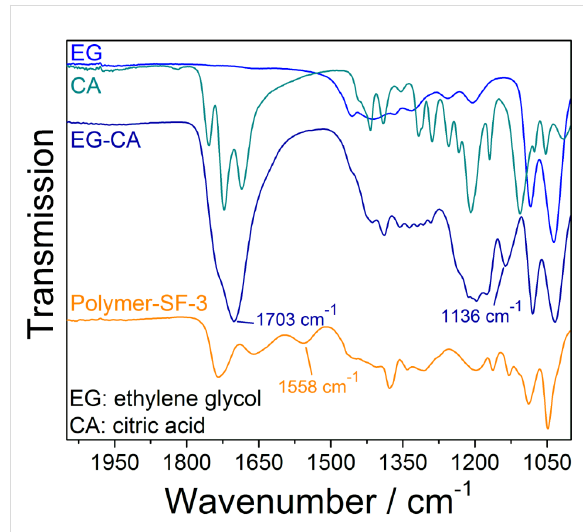
Figure 2: Infrared spectra of the monomers ethylene glycol (EG, blue) and citric acid (CA, green blue), the metal-free polymer achieved by 5 min ball milling with ZrO 2 balls ( d = 15 mm) (EG-CA, dark blue) and the polymeric precursor after adding titanium(IV) isopropoxide (Polymer-SF-3, orange).